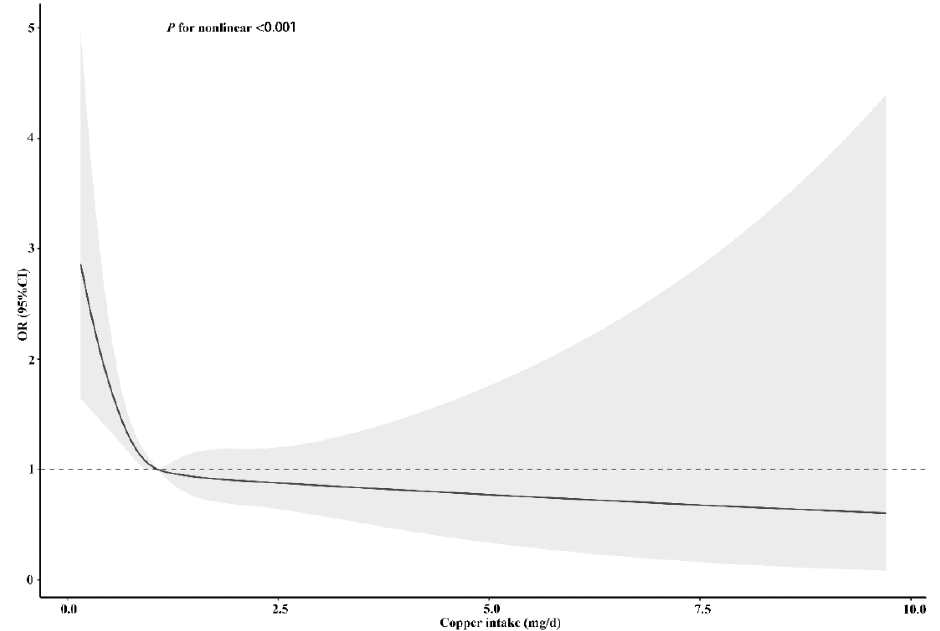
Figure 5. Restricted cubic spline models for the relationship between dietary copper intake and the risk of stroke before matching. The 95% CIs of the adjusted ORs are represented by the gray-shaded area. The model is adjusted for sex, age, race (Mexican American, other Hispanic, non-Hispanic white, non-Hispanic black, or other race), education (less than 9th grade, 9–11th grade, high school, graduate/GED or equivalent, some college or AA degree, or college graduate or above), PIR, marital status (married/living with partner, widow/divorced/separated, or never married), insurance, smoking, hypertension, HDL, asthma, arthritis, diabetes (yes, no, or borderline), general health (excellent, very good/good, or fair/poor), PHQ-9 depression score, trouble sleeping, and epilepsy. OR, odds ratio.